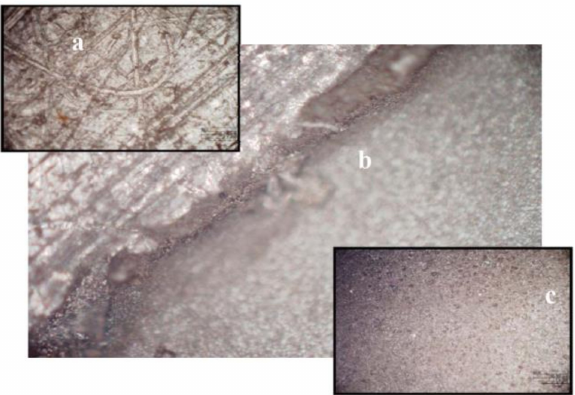
Figure 16. Digital microscopy of silver before electropolishing ( a ), along the electropolishing divide ( b ) and after electropolishing in ethaline ( c ) (reprinted with permission from ref. [56]; Copyright 2010 The Electrochemical